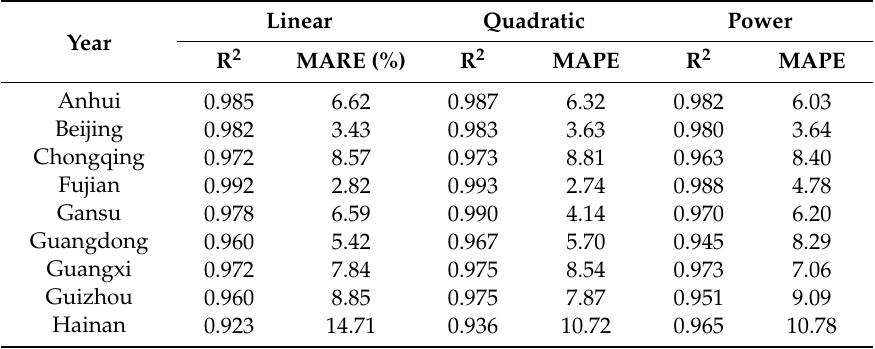
Table 10. Model fitting precision values between TNL and EPC in time